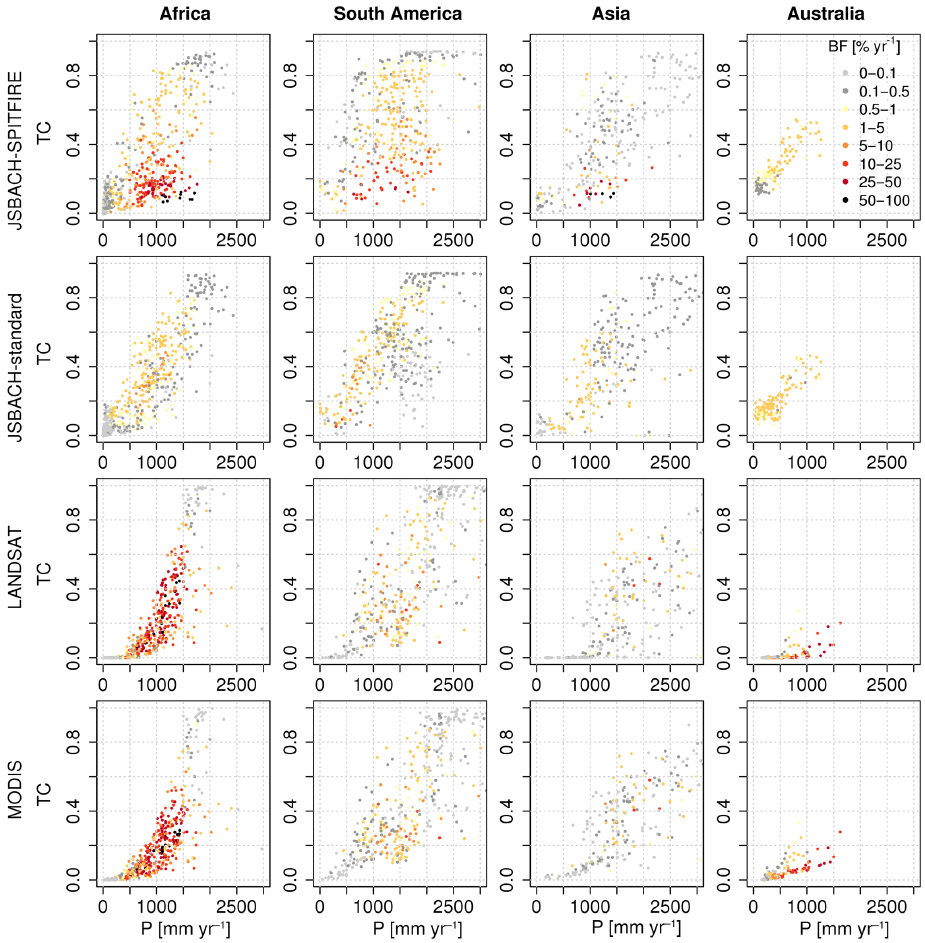
Figure 4. Modelled and observed tree cover (TC) versus precipitation ( P ), and colour-coded burned area fraction (BF). Satellite data sets were aggregated to model grid resolution (1.875 ◦ ).